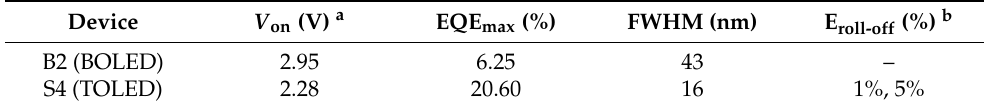
Table 2. Summary of the performance of the BOLEDs and TOLEDs. Device